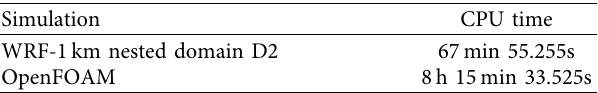
Table 2: CPU time of two simulations: a 1km simulation using WRF and a LES using